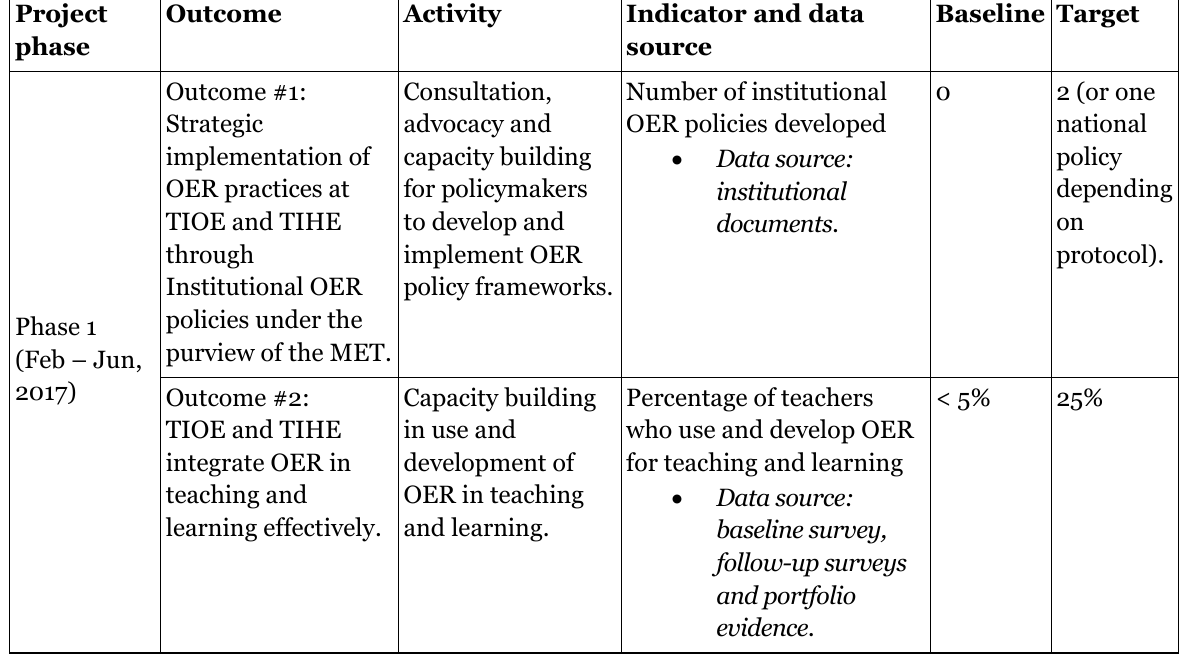
Project Evaluation Chart for the Strategic OER Implementation Project in Tonga